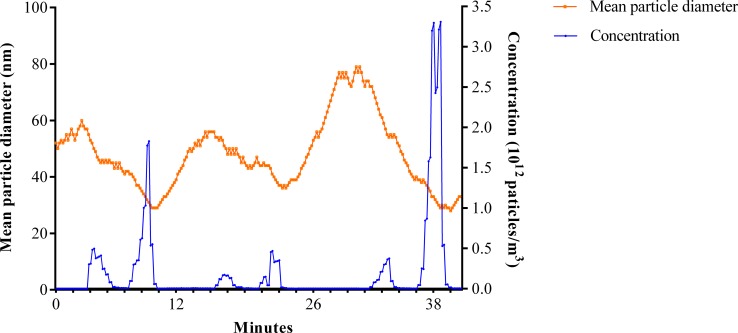
Particle size and concentration distributions of ultrafine particles generated from drilling teeth procedures.